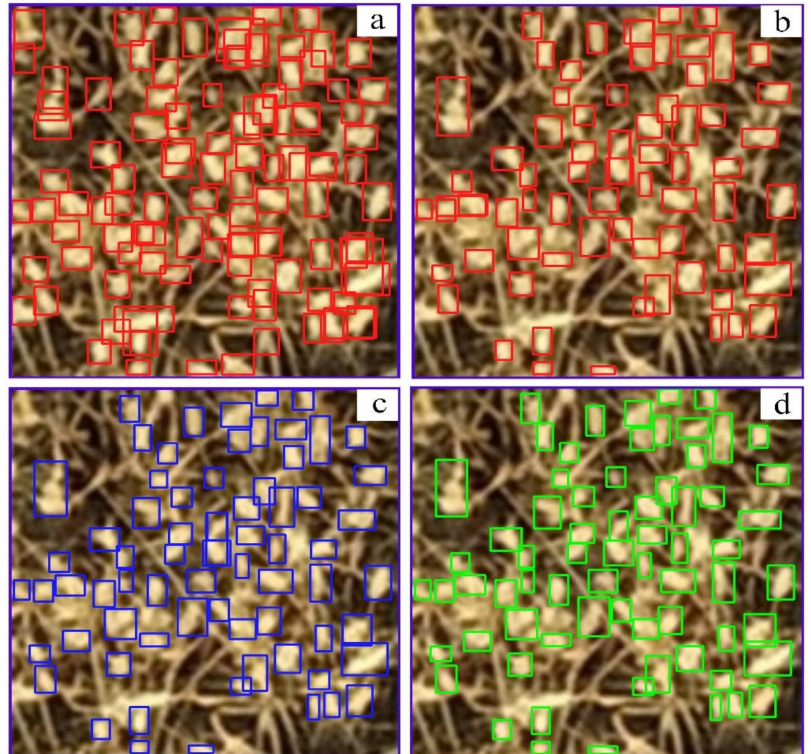
Figure 10. Detection results after fusing multiresolution detection boxes using the WBF algorithm. Detection boxes on 150 × 150 images ( a ), detection boxes on 600 × 600 images ( b ), fused boxes based on the WBF ( c ), ground truth of wheat spike bounding boxes ( d